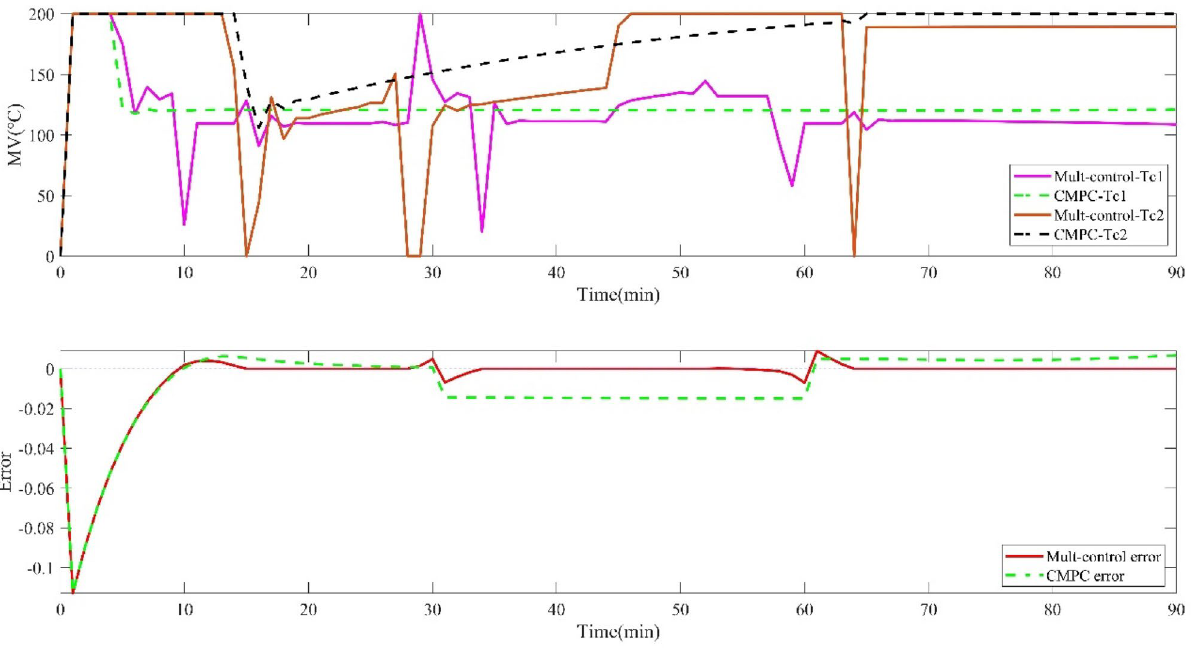
Figure 5. Operation variables of drying process and outlet moisture error of cutting tobacco under disturbance